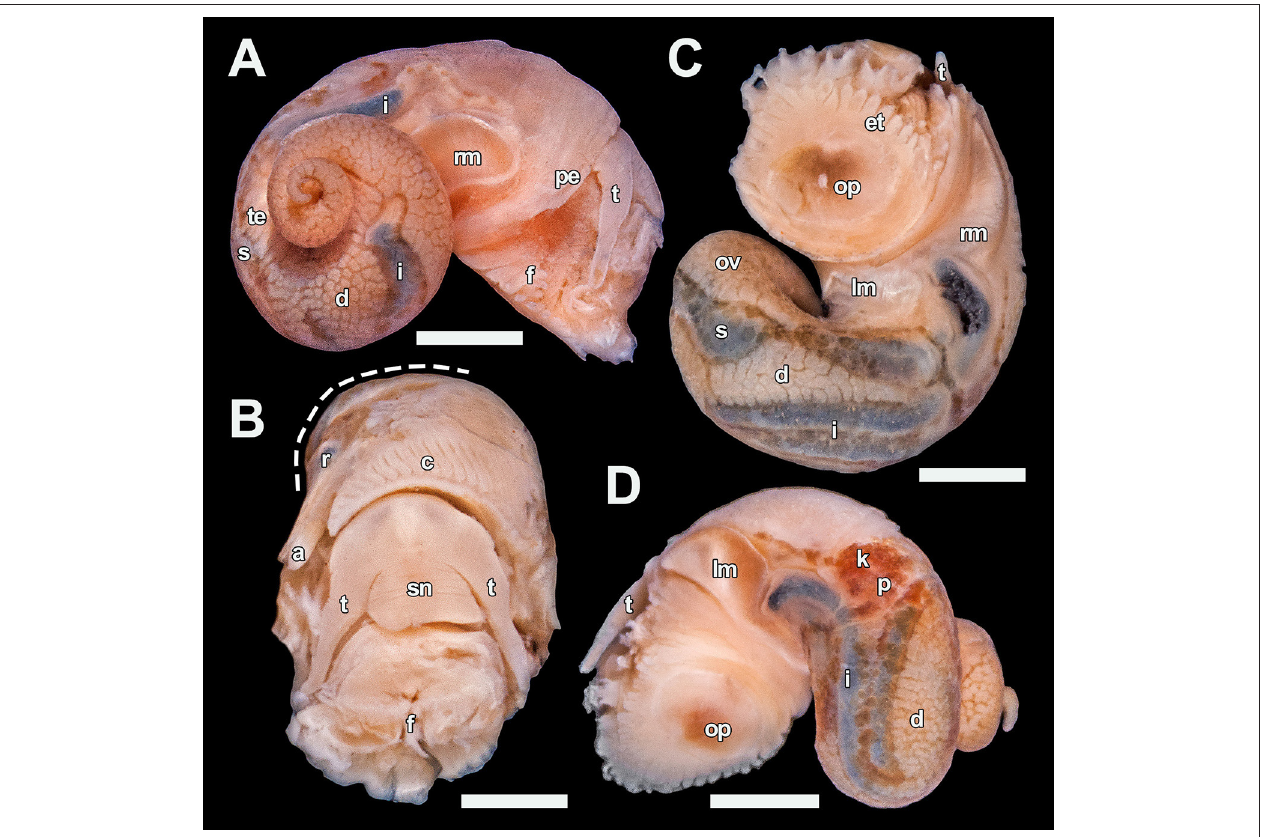
FIGURE 4 | Lirapex politus n. sp. soft parts, paratype 5 (UMUT RM32665). (A) Right view, (B) Anterior view with part of the mantle roof removed to expose the ctenidium (visceral mass cut away at dashed line), (C) Ventral view, (D) Left view. Scale bars: (A), (C,D) 1mm, (B) 0.5mm. a, anus; c, ctenidium; d, digestive gland; et, epipodial tentacle; f, foot; i, intestine; k, right kidney; lm, left columellar muscle; ov, ovary; op, opercular attachment; p, pericardium; pe, pallial edge; r, rectum; rm, right columellar muscle; s, stomach; sn, snout; t, cephalic tentacle; te,